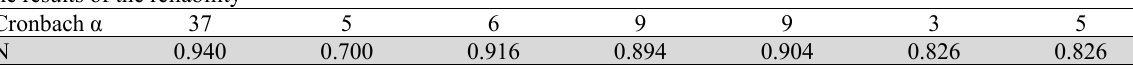
The results of the reliability